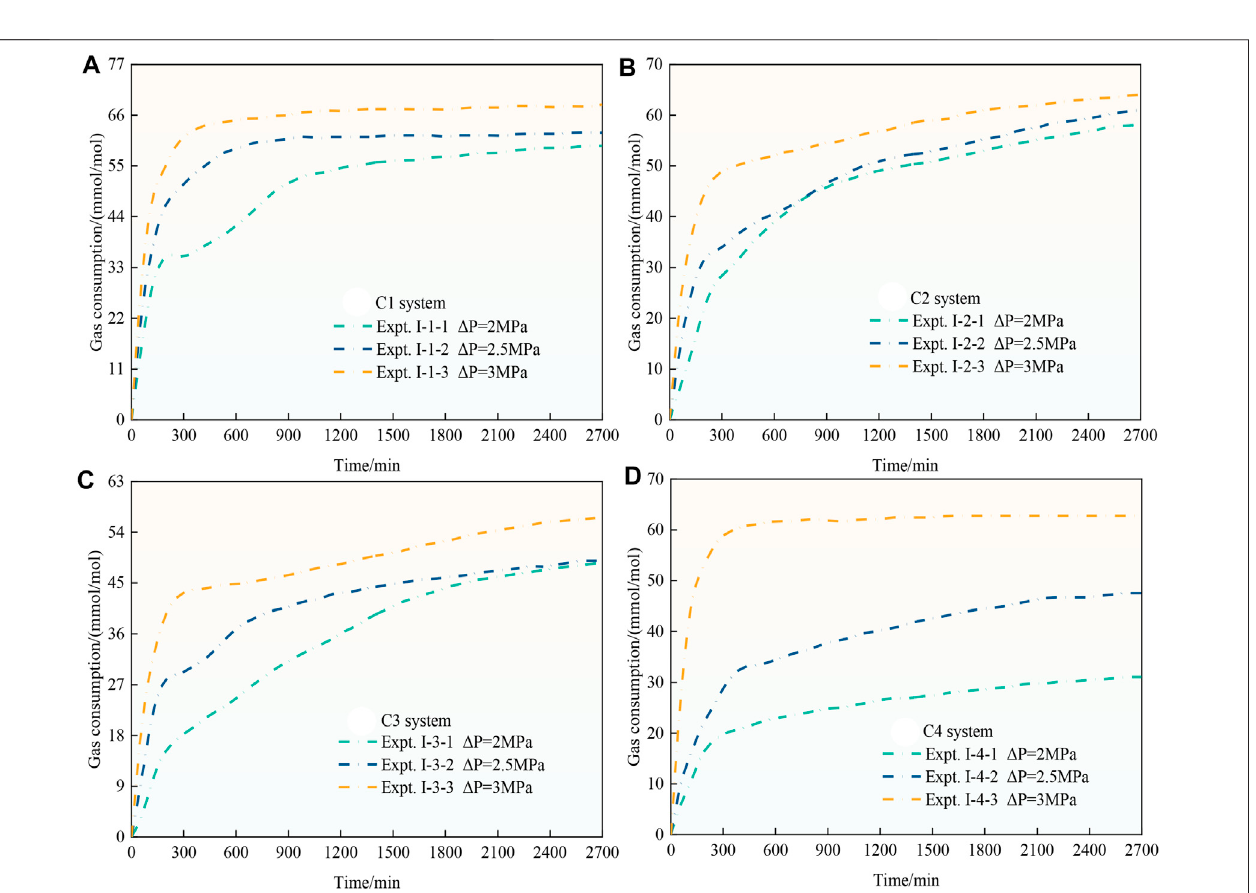
FIGURE 4 | Gas consumption of CO 2 hydrates in the C1-C4